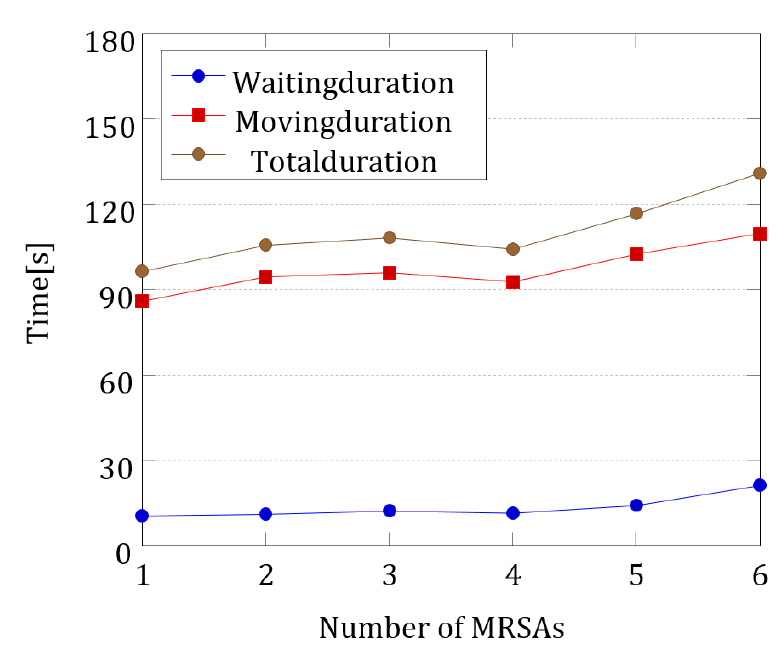
Figure 15. Durations of the states in the WRA.